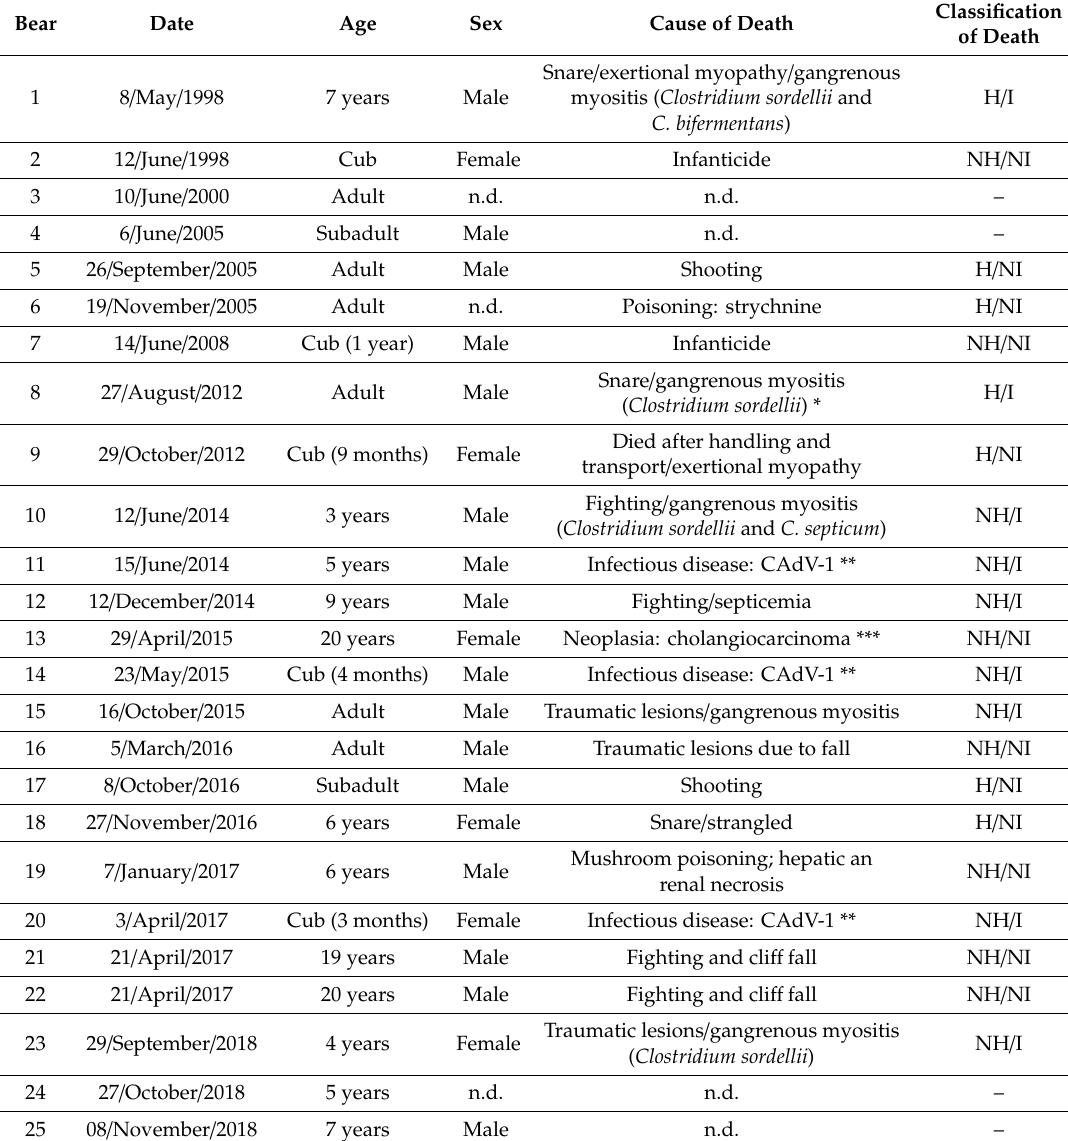
Table 1. Available data, cause of death, pathologic findings and classification of death of twenty-five free-ranging Eurasian brown bears ( Ursus arctos arctos ) necropsied from 1998 to 2018 in Asturias and Castilla y Le ó n (northwestern